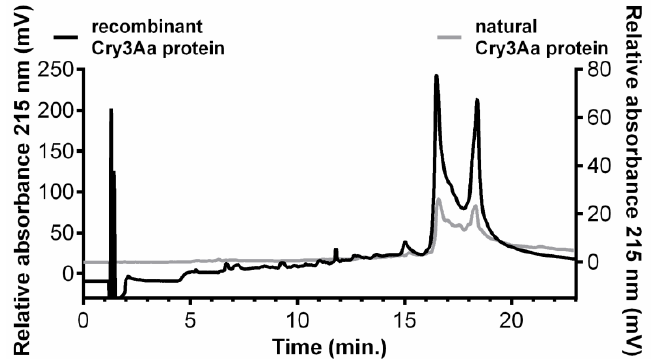
Figure 1. The RP HPLC elution profiles of recombinant Cry3Aa (left y -axis) and natural Cry3Aa (right y -axis) solutions (200 μL) .